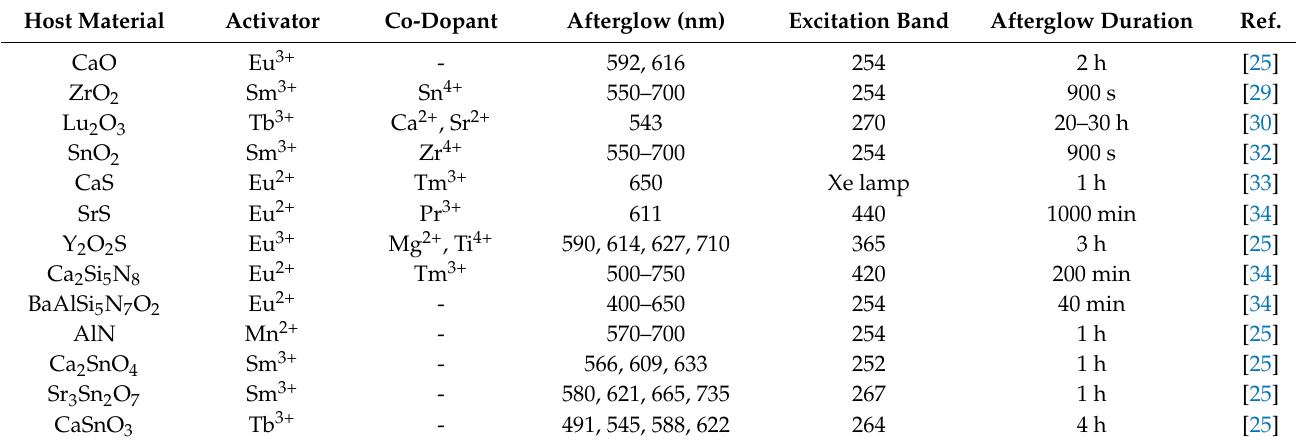
Table 3. Selected optical properties of phosphors